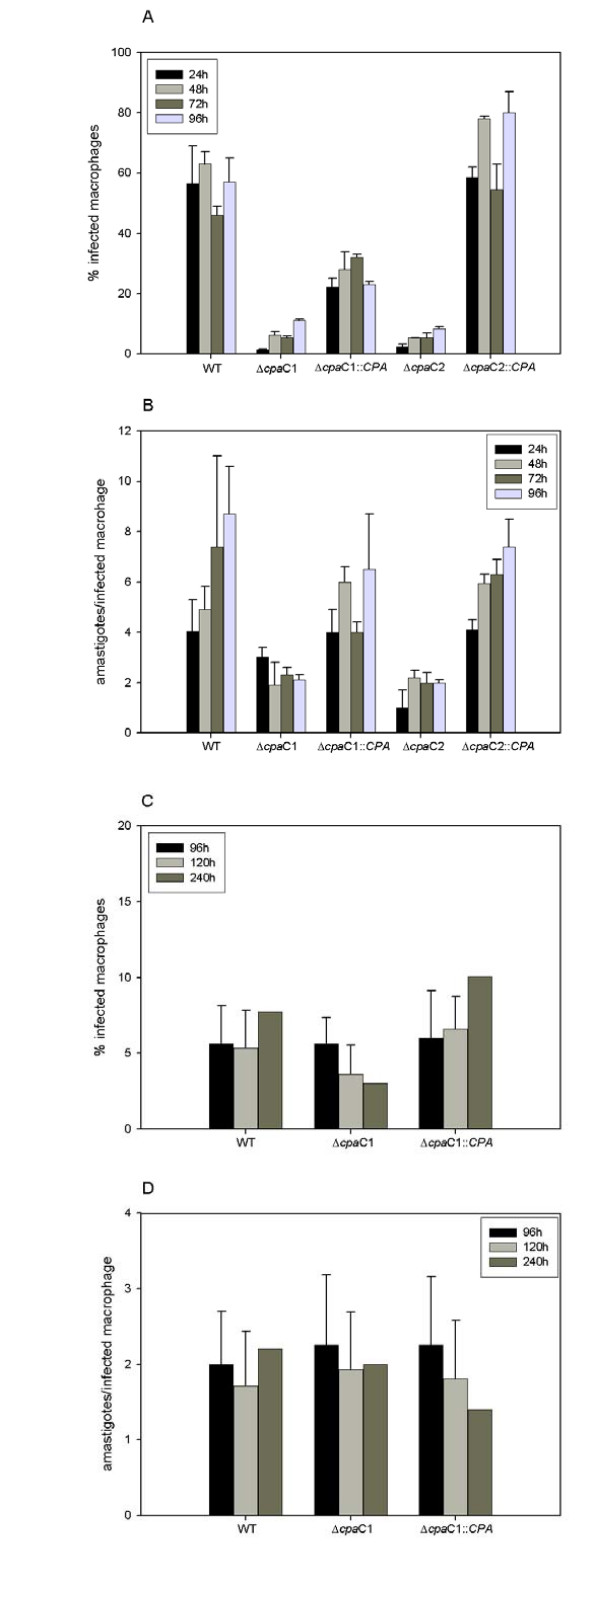
LiCPA mutant infectivity in vitro. Human monocyte cells (U937) were infected with wildtype (WT), CPA null mutants (ΔLicpaC1, ΔLicpaC2) or re-expresser clones (ΔLicpaC1::CPA, ΔLicpaC2::CPA) of L. infantum. Cell cultures were monitored for four days; results are presented as the percentage of infected macrophages and the number of amastigotes per infected cell in panels A and B, respectively. Similar experiments were performed in a canine monocyte cell line (DH82) using WT, ΔLicpaC1 and ΔLicpaC1::CPA L. infantum clones. Cell cultures were monitored for five to ten days after infection; results are presented in panels C and D. Depicted values at 96 and 120 hrs incubation are the mean of four independent experiments and error bars indicate the standard deviation. The data for the ten day incubation period is derived from one experiment, hence the absence of a standard deviation.